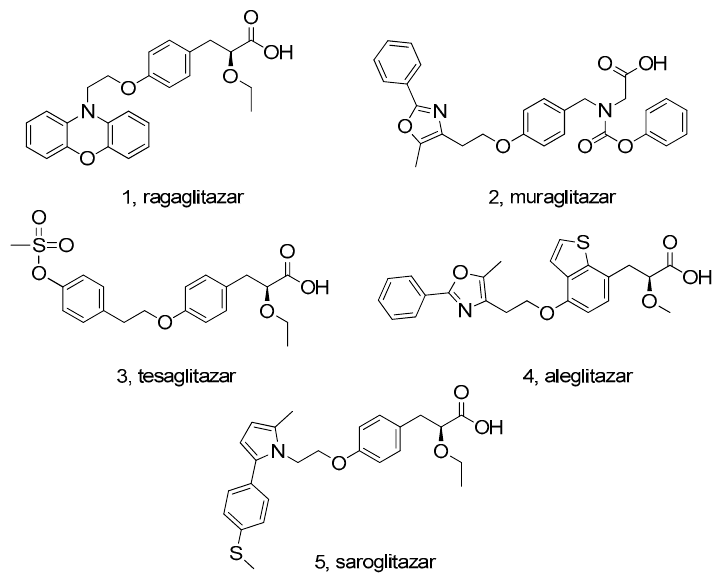
Figure 1. Chemical structures of selected glitazars ( 1–5 ).